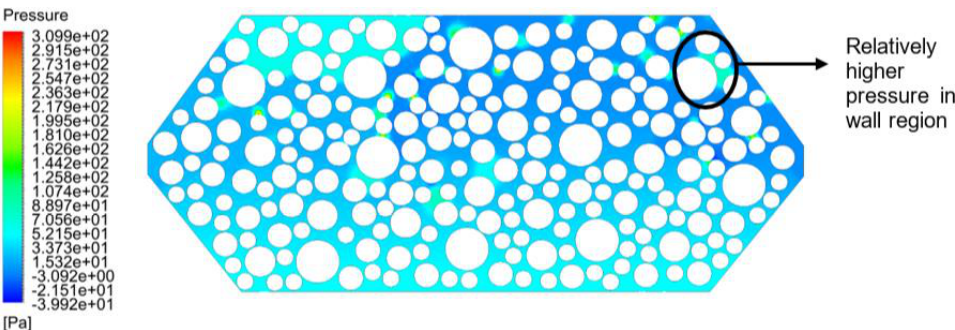
Figure 13. Contours of pressure for case 3 at 300 s.